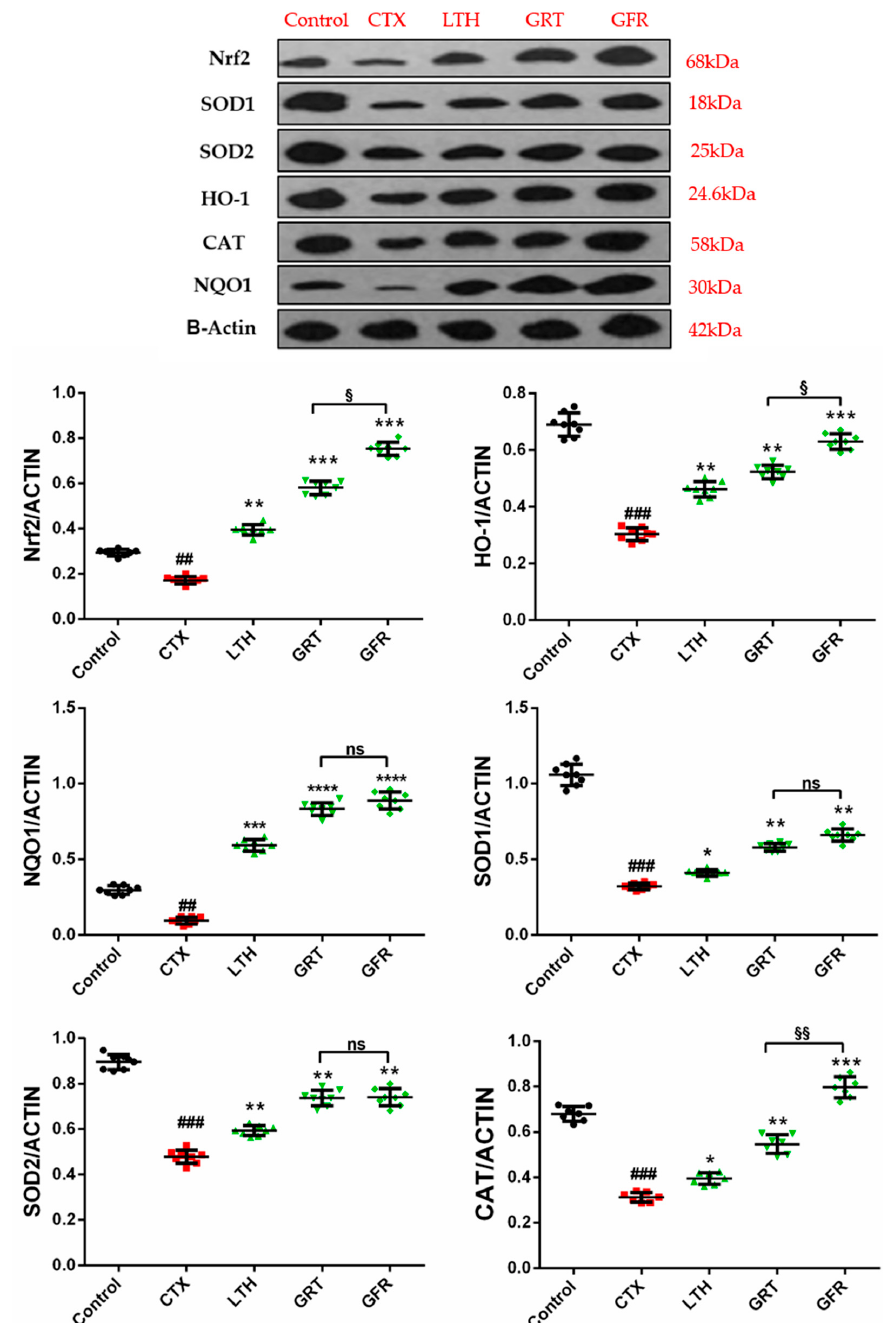
Figure 5. Effect of various parts of ginseng on the expression levels of nuclear factor-erythroid 2 related factor 2 (Nrf2), heme oxygenase-1 (HO-1), NADPH quinine oxidoreductase-1 (NQO1), superoxide-dimutase-1 (SOD1), superoxide-dimutase-2 (SOD2), and Catalase (CAT) in the spleen of mice with CTX-induced immunosuppression. The values are presented as mean ± SD, n = 10. ### p < 0.001 and ## p < 0.01 compared with the control group. *** p < 0.001, ** p < 0.01 and * p < 0.05 compared with the CTX group. §§ p < 0.01, § p < 0.05, ns p > 0.05 compared with the GRT group.